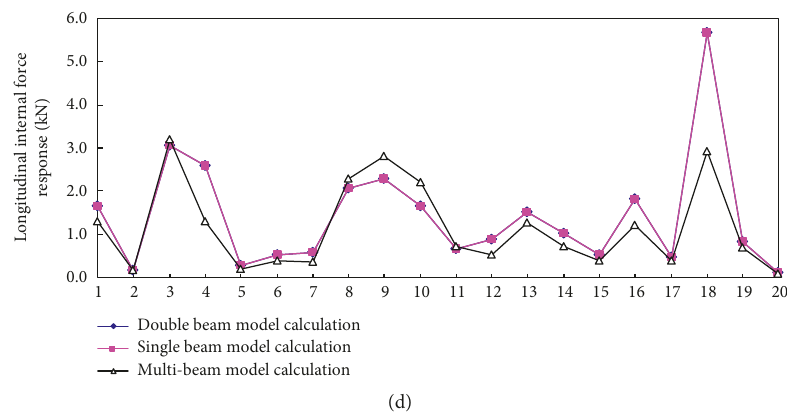
Figure 8: Support longitudinal internal force response. (a) No. 1 support. (b) No. 2 support. (c) No. 3 support. (d) No. 4